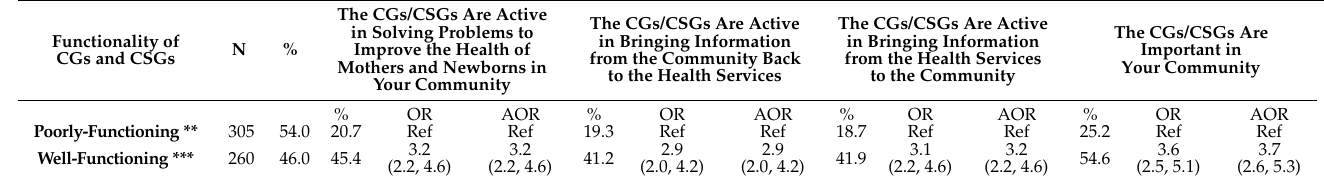
Table 4. Association between the functionality of CGs and CSGs and women’s perception of the role of CGs and CSGs; (N =